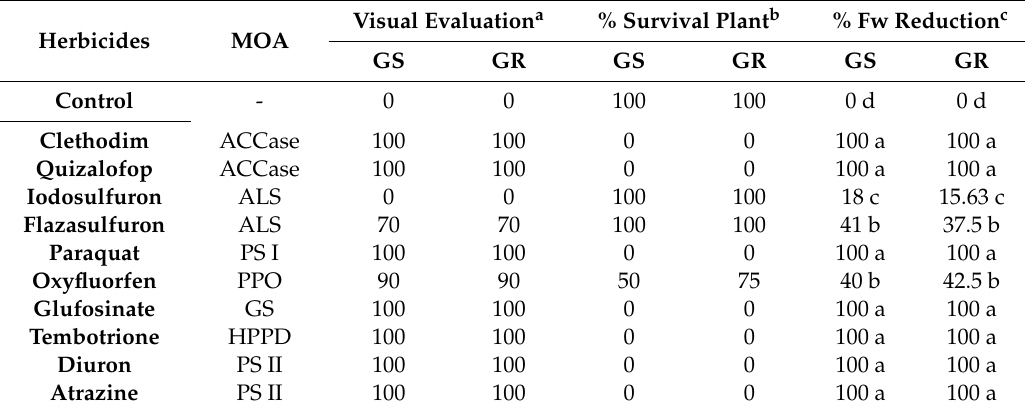
Table 4. Alternative herbicides used to control C. distichophylla GR and GS populations after 28 DAT, visual evaluation, survival plant, and fresh weight (Fw)